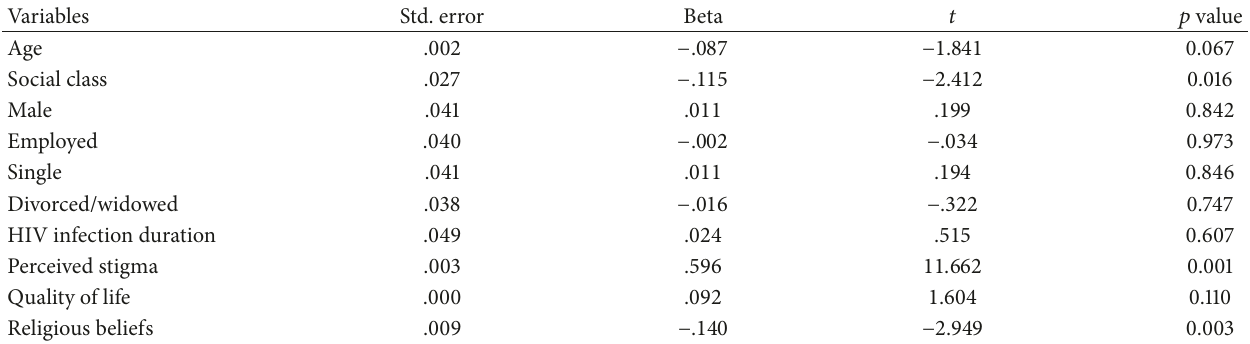
Table 4: The linear multiple regression for suicidal ideations as a dependent